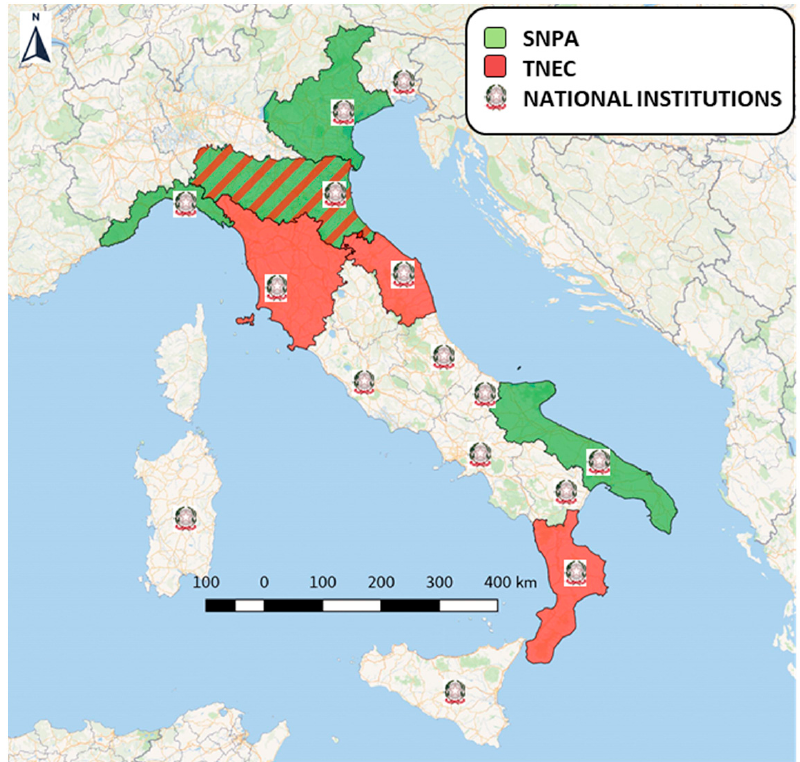
Figure 3. Geographical distribution of the Institutions’ responses.